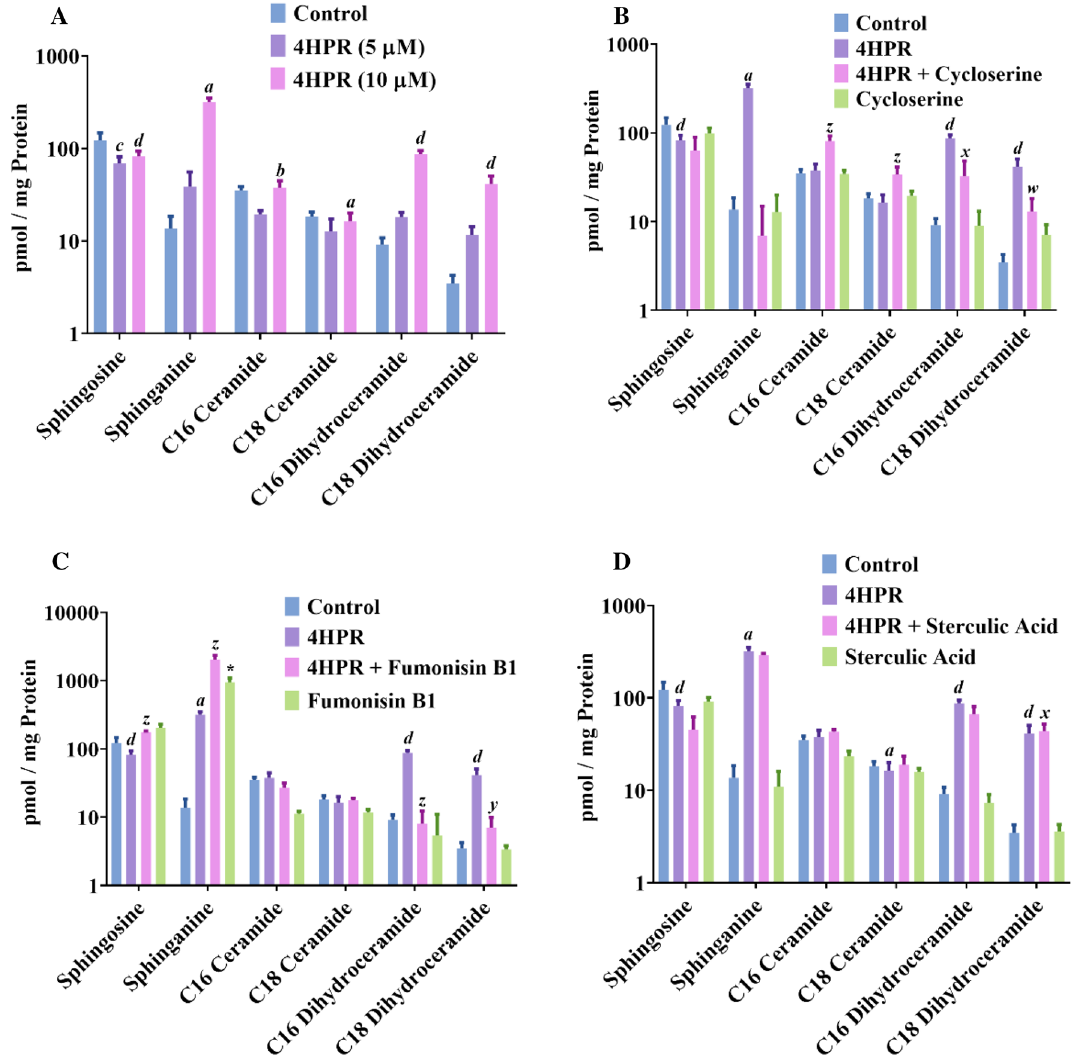
Figure 4. Inhibition of ceramide synthesis by fenretinide in ARPE-19 cells. ARPE-19 cells were treated with or without fenretinide for 16 h in the presence or absence of various specific inhibitors, and lipids were extracted and analyzed by LC–MS as described under “Experimental Procedures”. ( A ) the effect of fenretinide on various ceramide analogs. ( B ) the effect of l-cycloserine on fenretinide-induced ceramide synthesis. ( C ) the effect of fumonisin B1 on fenretinide-induced ceramide synthesis. ( D ) The effect of sterculic acid (SA) on fenretinide- induced ceramide synthesis. Ceramide and sphingolipid peak areas are expressed normalized to protein concentration and plotted on log scale (log 10 ) due to the large differences in levels between treatment groups and untreated controls. Results are representative of 2 independent experiments analyzed in 3 or 6 repetitions and are shown as mean ± SD. To test for significant differences between treatment groups, one-way analysis of variance (ANOVA) was used. When significant treatment effects were found, the Tukey–Kramer multiple comparison test was used to determine whether there were significant differences between individual treatment groups. In the graphs, a , b , c and d indicates statistical significance difference between fenretinide treated and untreated controls ( a p < 0.01; b p < 0.05; c p < 0.001; d p < 0.0001), w, x, y and z indicate statistical significance difference between fenretinide treated and fenretinide treated with inhibitors ( w p < 0.01; x p < 0.05; y p < 0.001; z p < 0.0001), and * indicate statistical significance difference between control and Fumonisin B 1 treated (*p < activity of NF-κB. As expected, NF-κB transcriptional activity was increased by fenretinide treatment (Fig. 6C). In particular, we found an increase in NF-κBp50 and NF-κBp65, the most common heterodimer of the NF-κB signaling pathway. However, sterculic acid pretreatment prevented the fenretinide-induced activation of both NF-κBp50 and NF-κBp65.